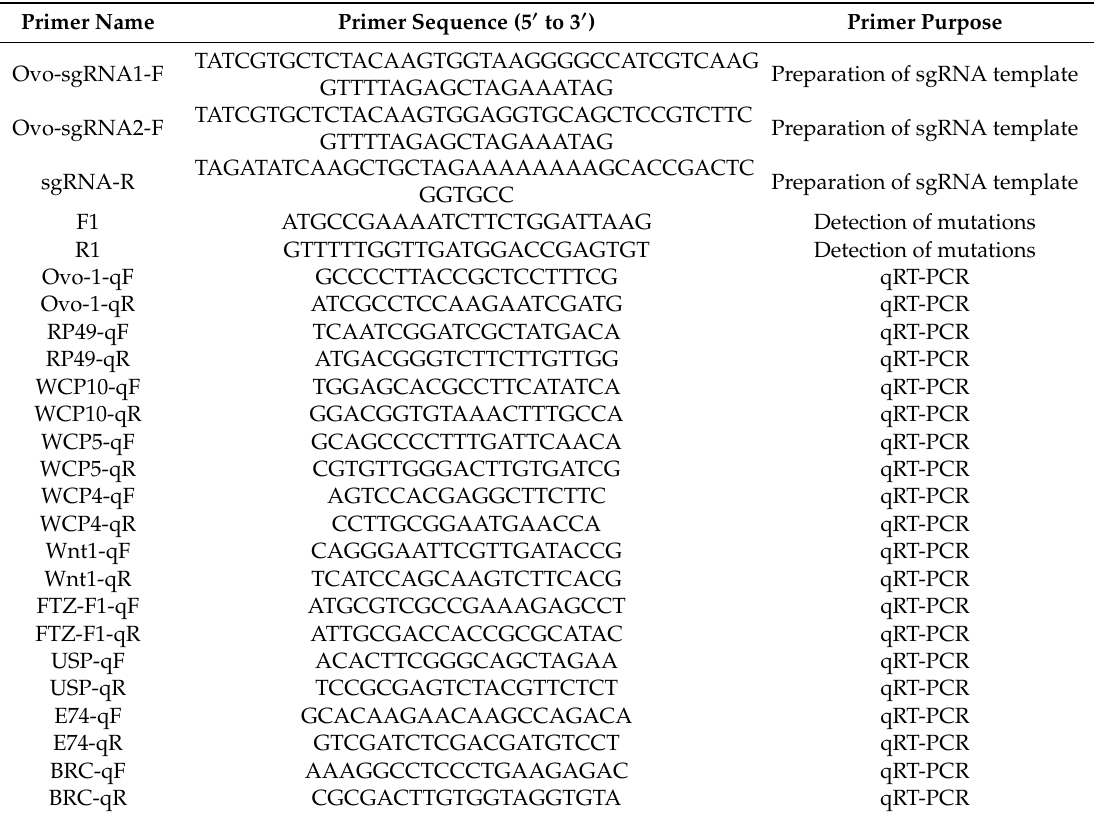
Table 1. Primers used in this